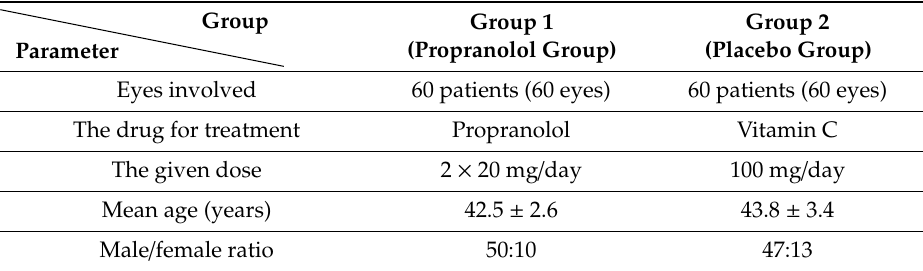
Table 2. The baseline characteristics of the propranolol and placebo